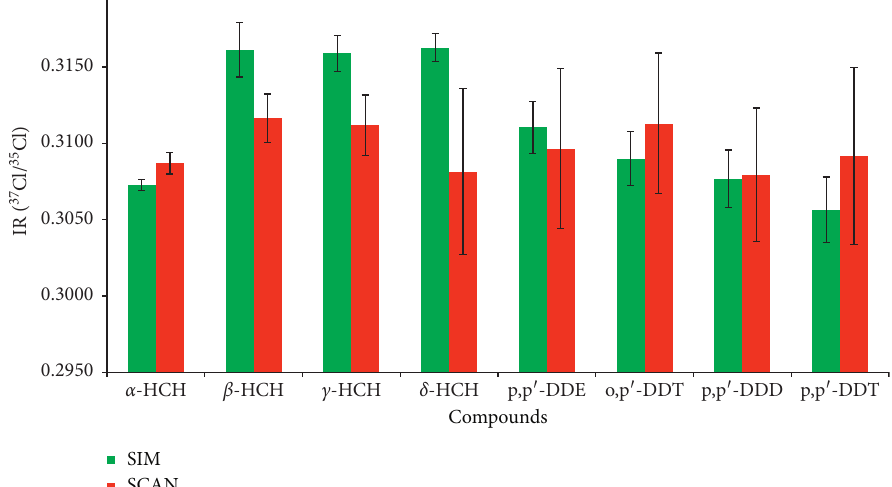
Figure 5: IR ( 37 Cl/ 35 Cl) values and precisions from single ion monitoring (SIM) and scan mode (SCAN). Error bars denote the standard deviations (1 σ ). Eight organochlorine pesticides: α -hexachlorocyclohexane ( α -HCH), β -hexachlorocyclohexane ( β -HCH), c -hexa- chlorocyclohexane ( c -HCH), δ -hexachlorocyclohexane ( δ -HCH), 1-chloro-2-[2, 2, 2-trichloro-1-(4-chlorophenyl) ethyl] benzol (o, p ′ -DDT), 2, 2-bis ( p -chlorophenyl)-1, 1, 1-trichloroethane ( p , p ′ -DDT), 2, 2-dichloro-1, 1-bis (4-chlorophenyl) ethylene ( p , p ′ -DDE), and 1, 1-dichloro-2, 2-bis ( p -chlorophenyl) ethane ( p , p ′ -DDD).